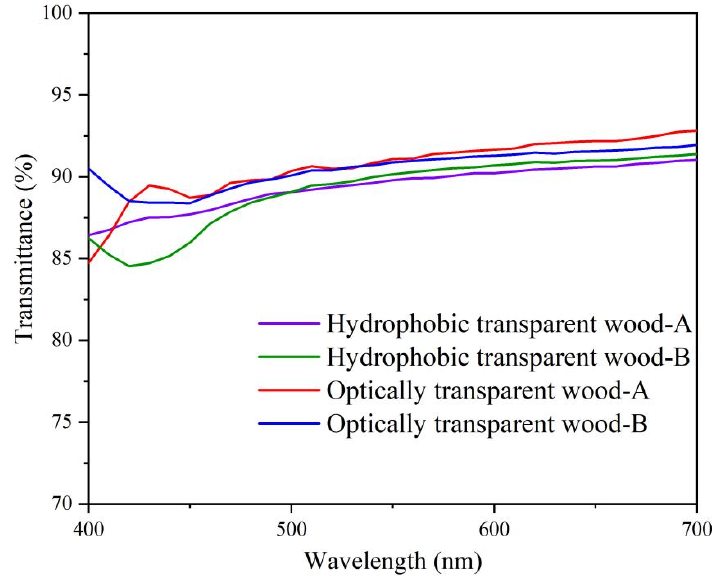
Figure 7. Transmi tt ance curves of OTW and HTW A and B